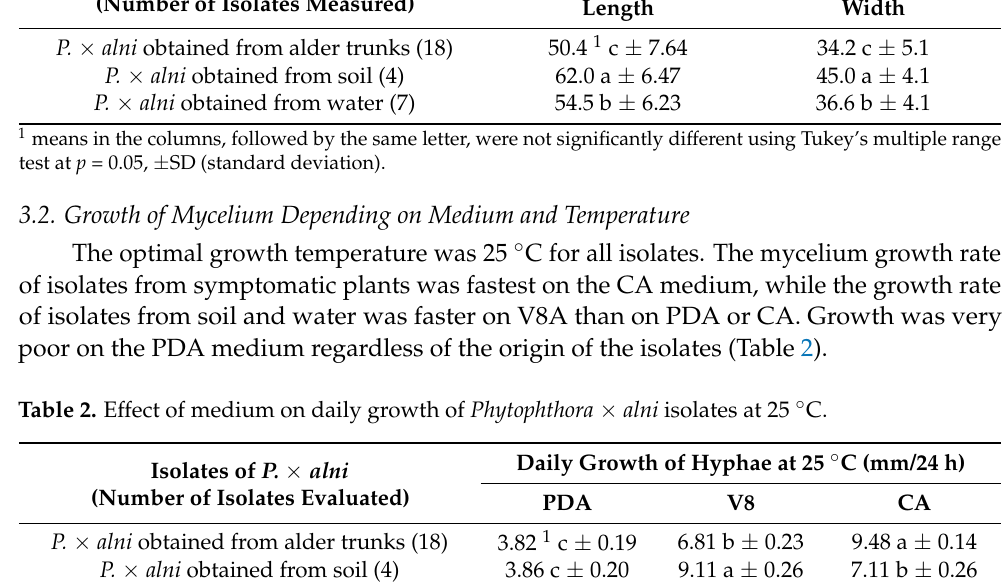
Table 1. Dimension of zoosporangia of Phytophthora × alni isolates (in µ m). Dimensions of Zoosporangia ( µ m) ± SD Isolates of P. × alni (Number of Isolates Measured) Length Width P. × alni obtained from alder trunks (18)